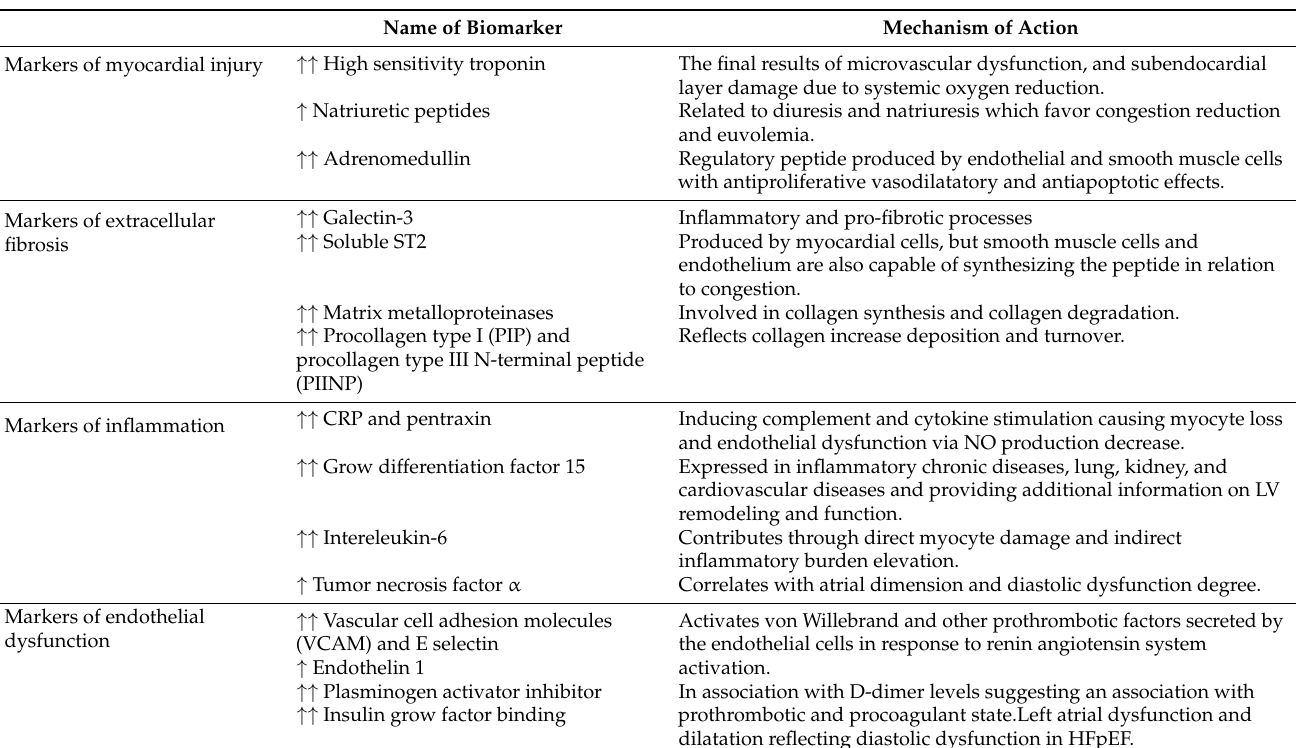
Table 1. Circulating biomarkers responsible for cardiac remodeling reflecting myocardial injury, collagen overexpression, inflammation, and vascular